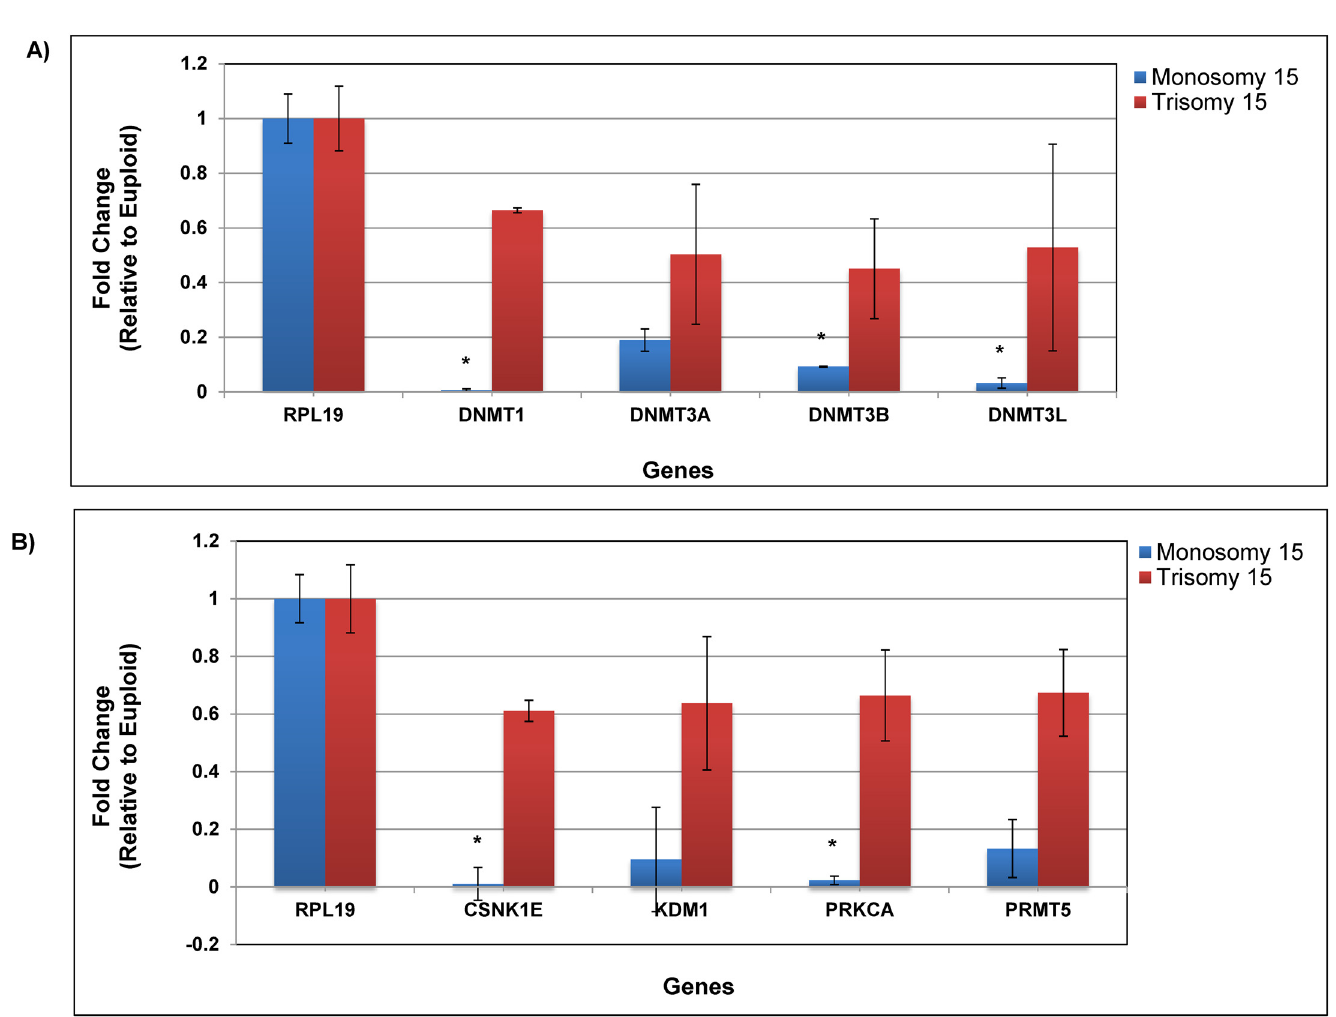
Fig 2. Epigenetic regulator expression in individual human blastocysts by qPCR (n = 12 replicates for each group). Ct values were normalized to RPL19 , an internal, constant housekeeping gene. Fold change was determined using the ΔΔ Ct method on the average of technical duplicates. Error bars represent standard error and the y-axis denotes fold change between euploid and aneuploidy. A) The expression of DNA methylatransferases was analyzed in euploid, trisomy 15, and monosomy 15 blastocysts ( * P < 0.05). B) The expression of post-translational regulators and the chromatin modifying protein, PRMT5 ( * P <